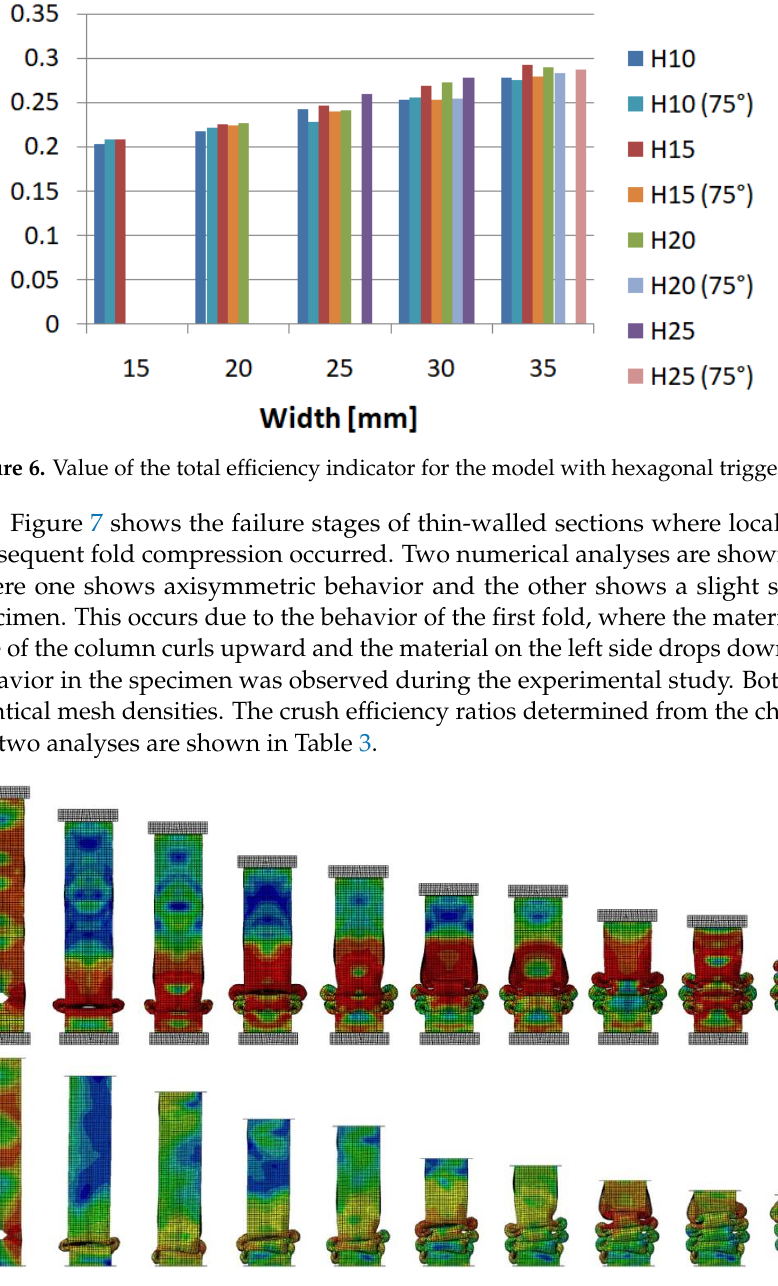
Figure 7. Comparison of mode for numerical simulation of the H10-15 specimen with and without skewness. Table 3. Crashworthiness indicator of two different crush types in the example of the H10-15 model.